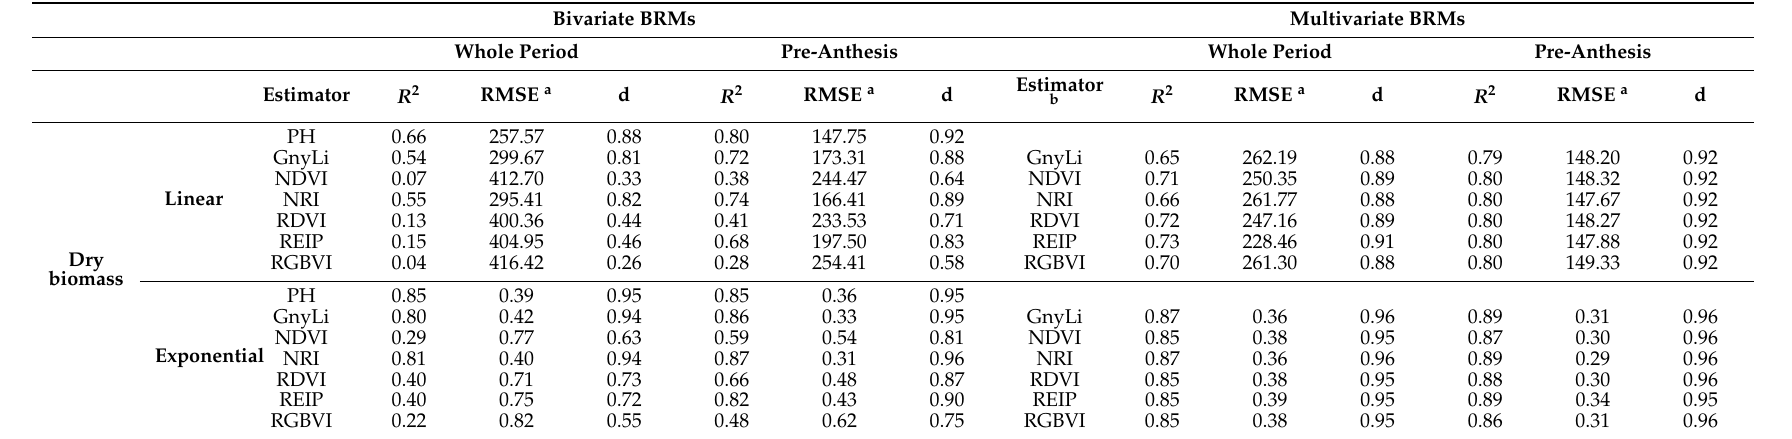
Table 3. Correction of Table 6 [1]. Statistics for the model validation as mean values of the four subset combinations ( R 2 : coefficient of